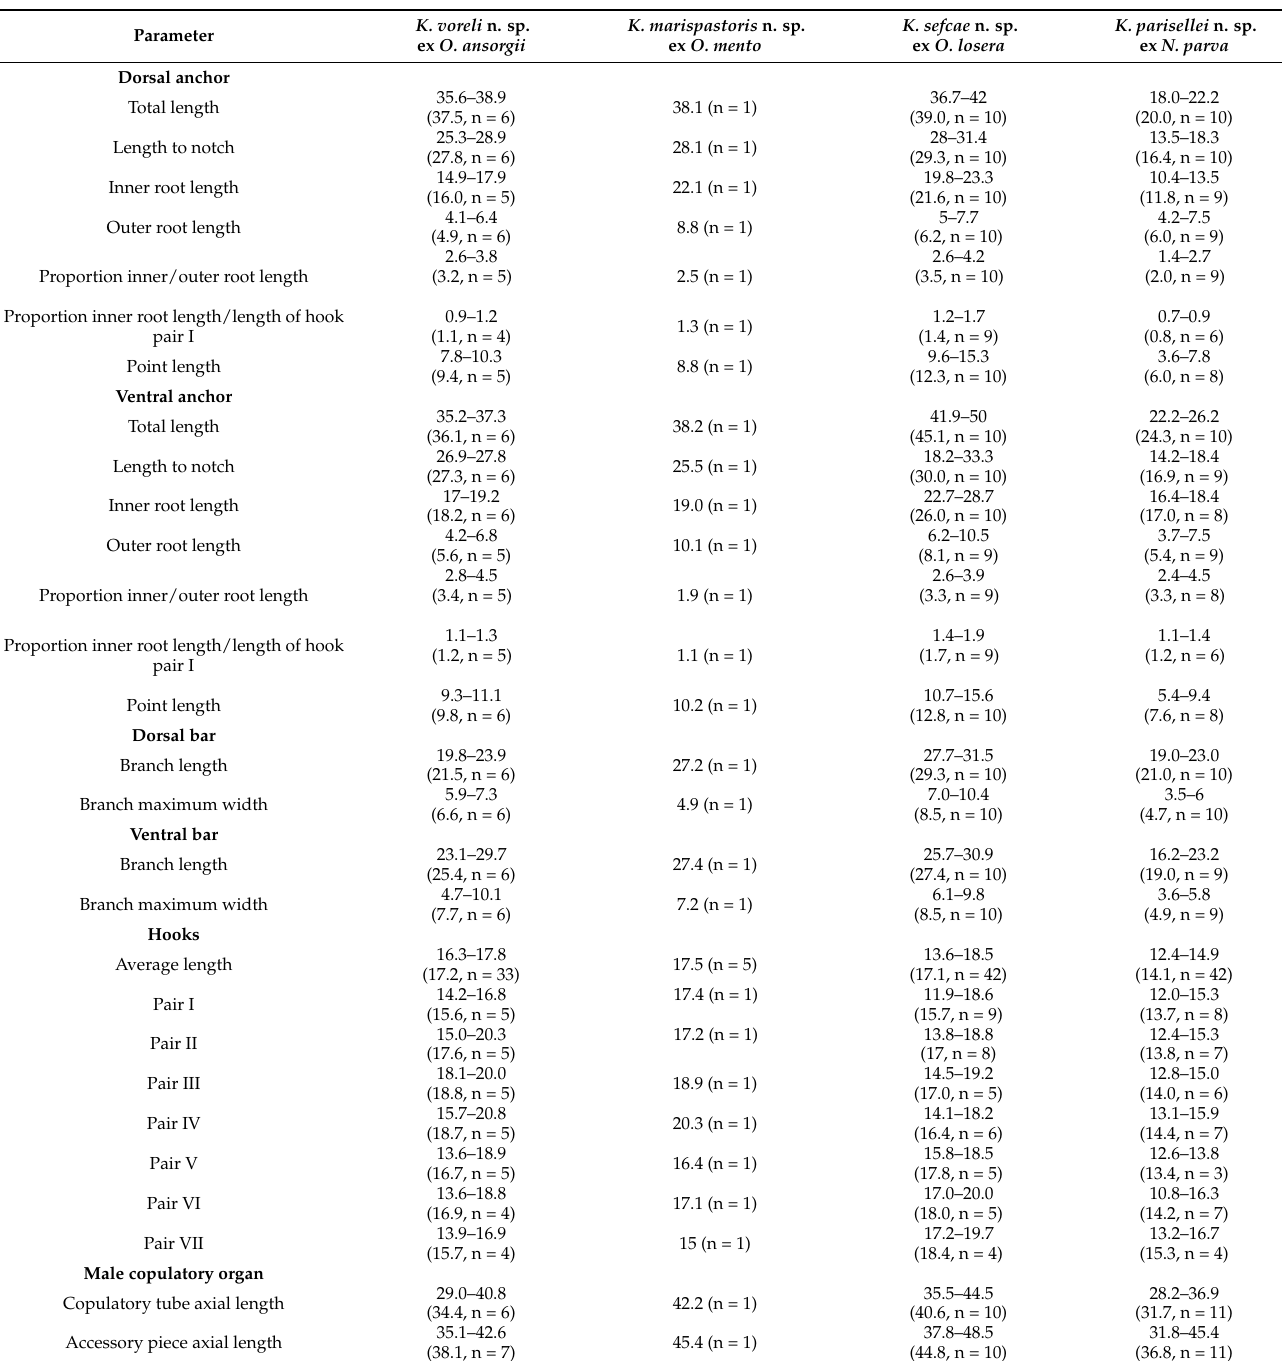
Table 2. Morphometric data ( µ m) for the newly described species of Kapentagyrus infecting representatives of Odaxothrissa and Nannothrissa . The measurements are presented as range followed by average and number of structures measured (n) in